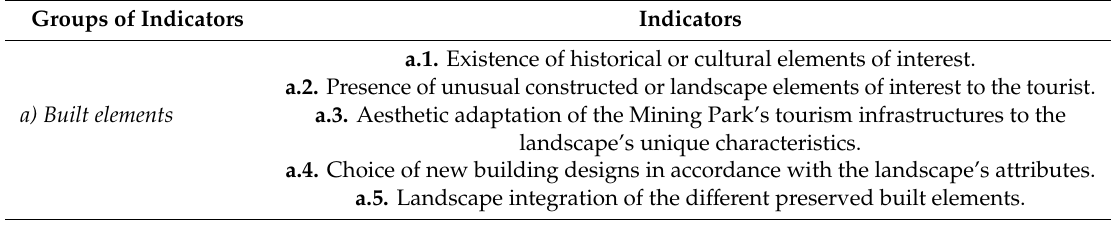
Table 1. Landscape analysis form: indicators and groups of